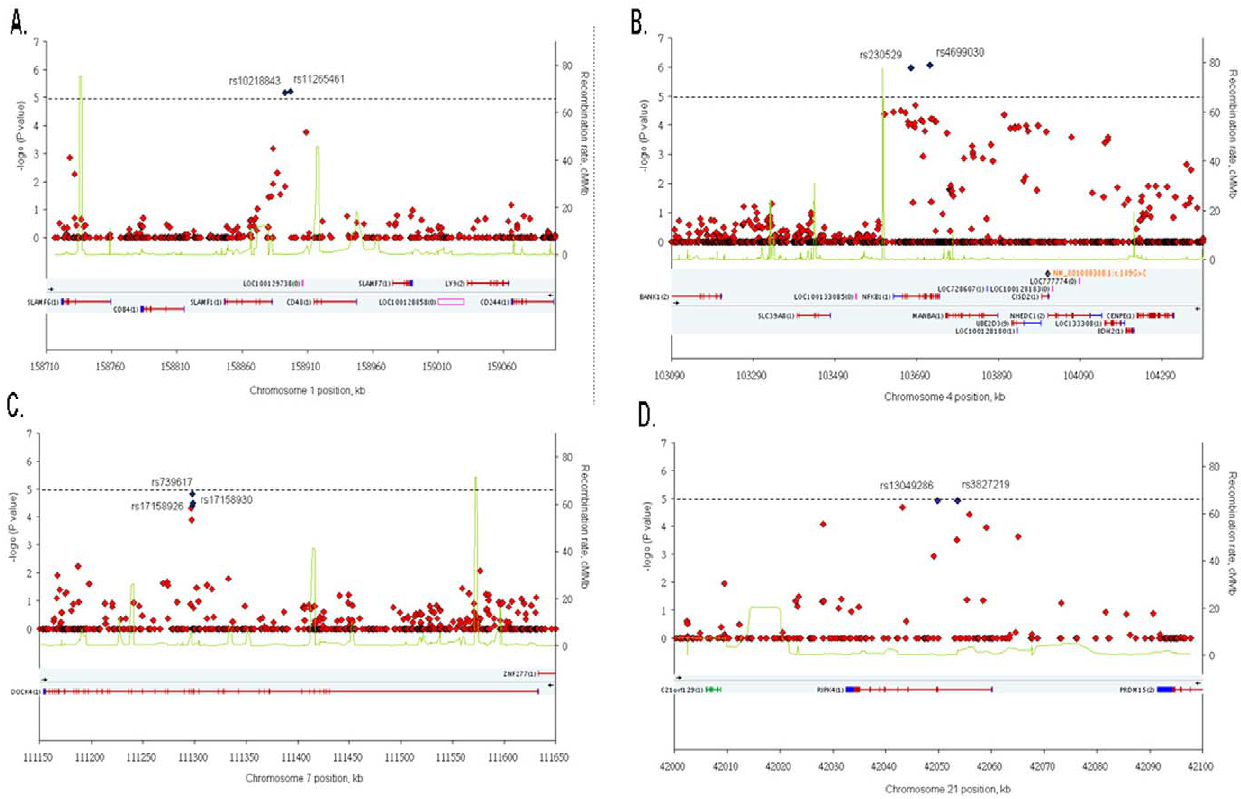
Figure 2. Refined regional association plots. For each plot of the four clusters ((A) SLAMF1 , (B) NFKB1 , (C) DOCK4 , and (D) RIPK4 ), the 2 log 10 P values for the trend test from Affymetrix SNP 6.0 Array in 522 cases and 806 controls are plotted as red diamond according to their genomic position (NCBI Build 36.3). The SNPs with the strongest signal are represented as blue diamonds. The recombination rates (right y-axis) based on the Chinese HapMap population is plotted as green lines to reflect the local LD structure around the SNPs. The dashed horizontal line indicates a P -value of 10 2 5 . ( P = 1.75 6 10 2 5 ), 60 kb upstream of zinc finger protein 492 ( ZNF492 ) on chromosome 19 (Table 2, Supplementary Figure S3).